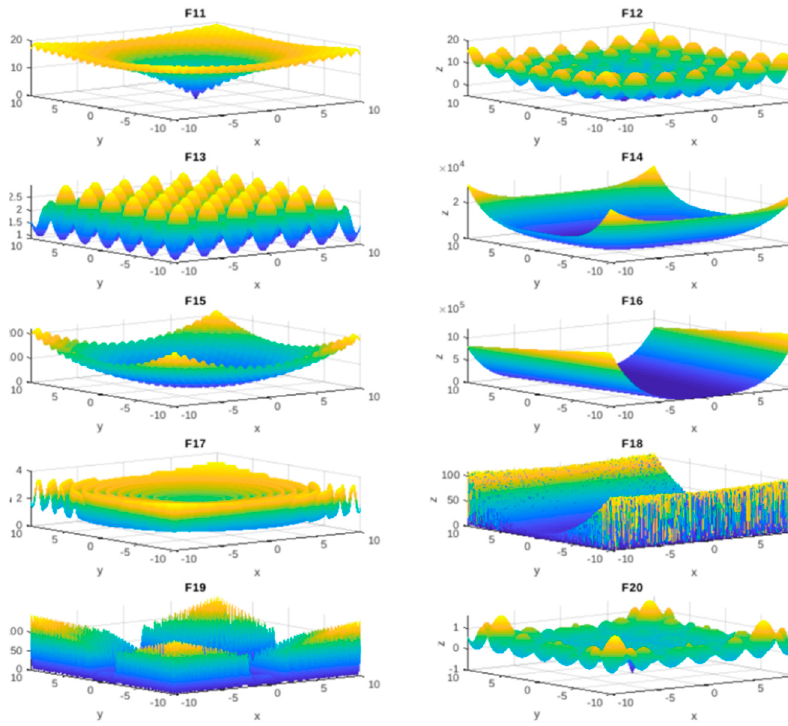
Figure A2. Testbench Multimodal functions.